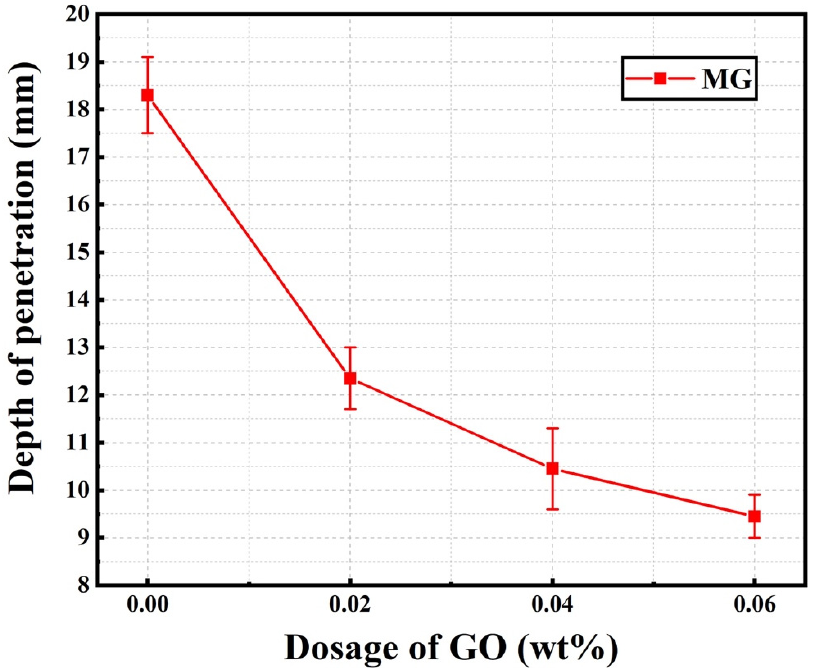
Figure 11. Chloride penetration depth of normal cement mortar samples (M, MG2, MG4, and MG6).